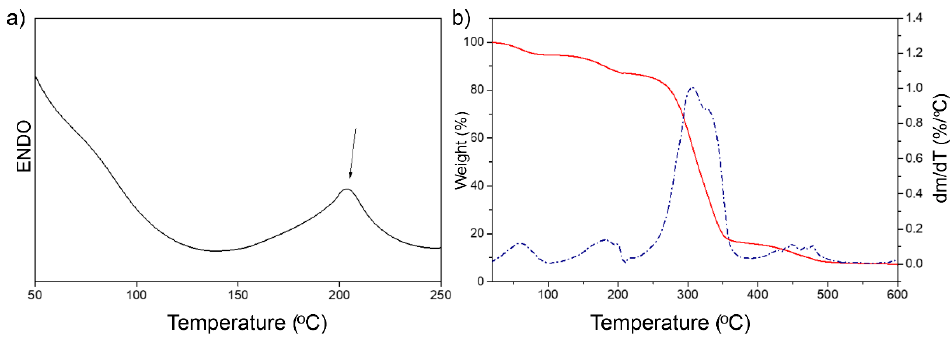
Figure 1. Representative ( a ) DSC thermogram and ( b ) TG/DTGA curves for tested PVA/TPS films.